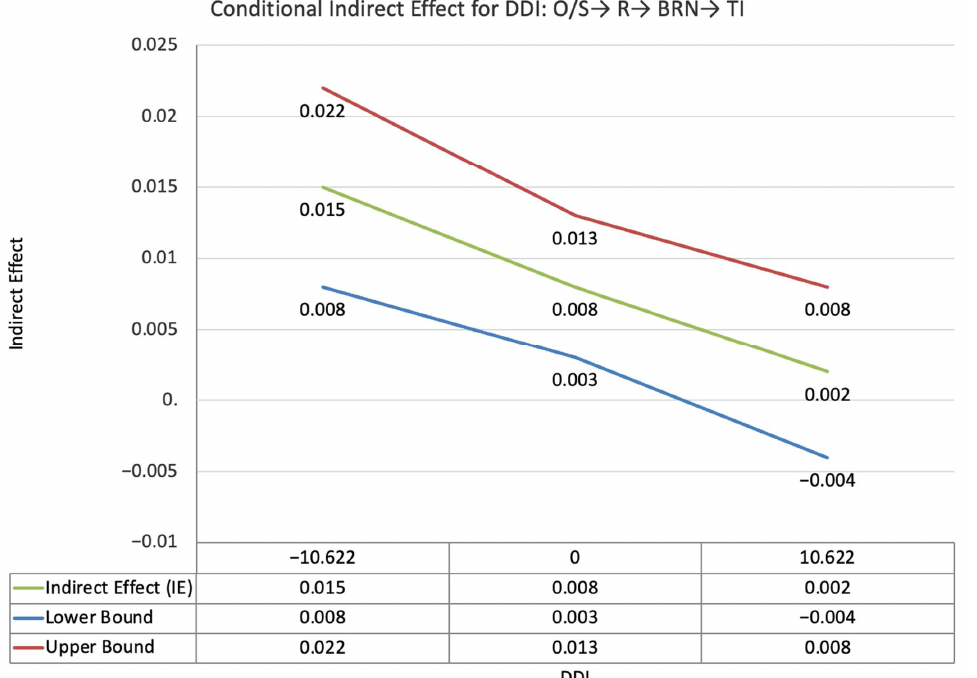
Figure 12. Conditional indirect effects of the difference between self-PMIEs compared to other- PMIEs on turnover intentions at low, average and high levels of self-disclosure, through relatedness satisfaction and burnout.